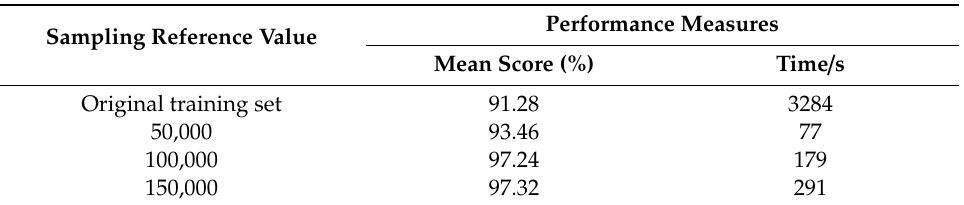
Table 8. Classification performance for di ff erent sampling references (feature set = F 0 , classifier = RF, R = 1.5 m).